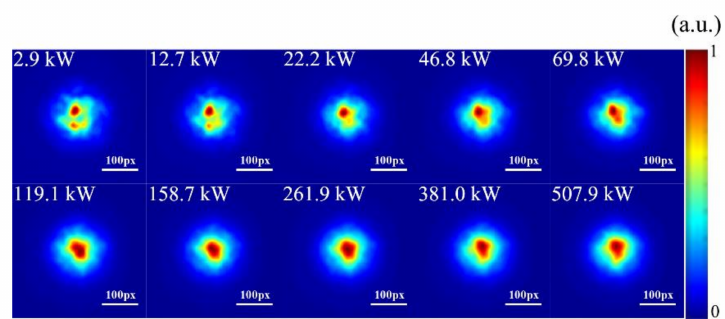
Figure 4. Output beam profiles from the MMF with a 3.6 cm tapered length under different input peak powers. (scalebar: 100